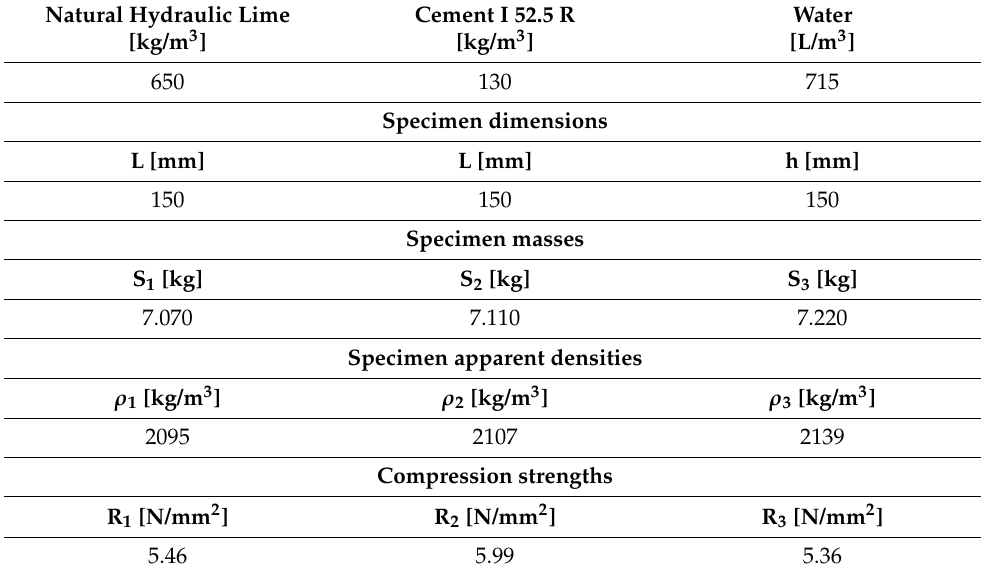
Table 5. Grout mixture. Physical and mechanical properties.